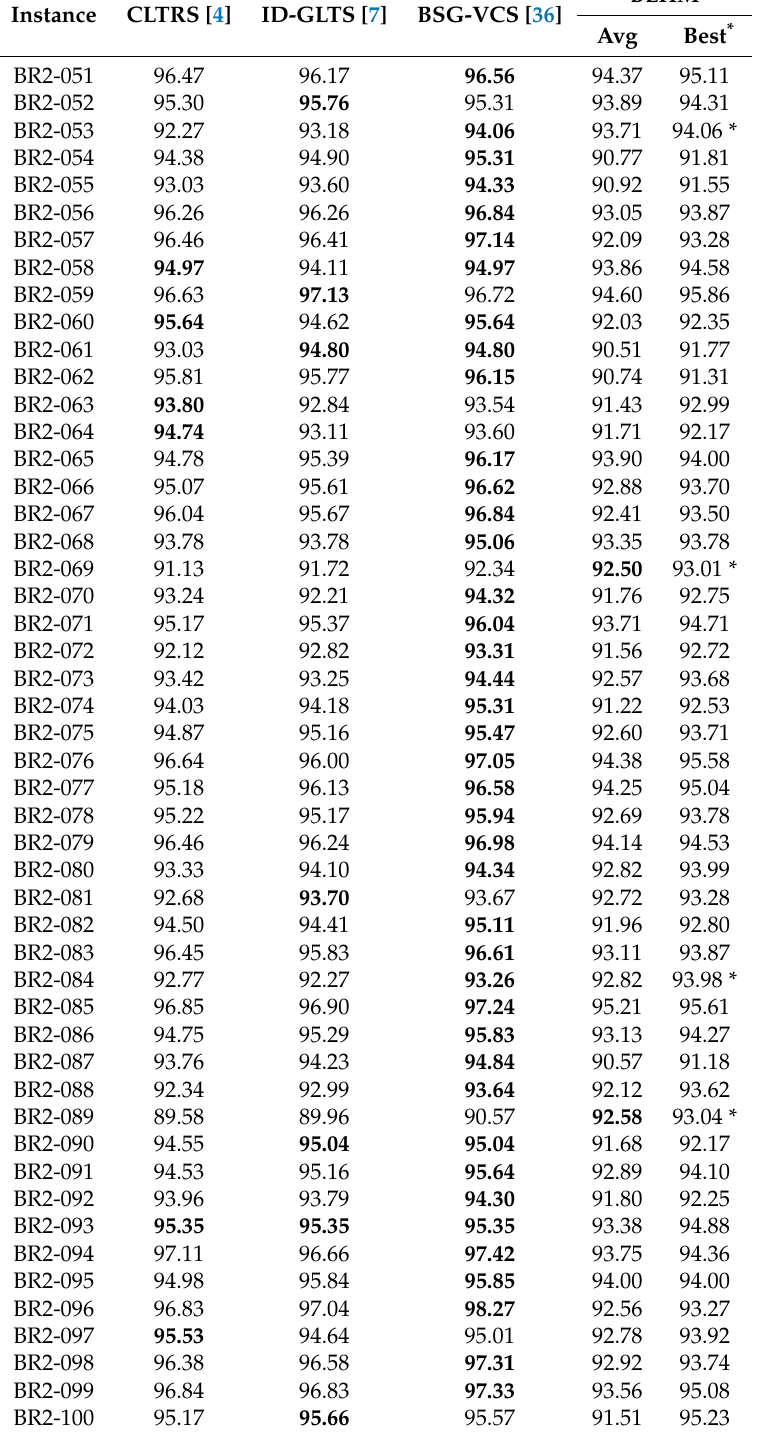
Table 4. Results for group BR2